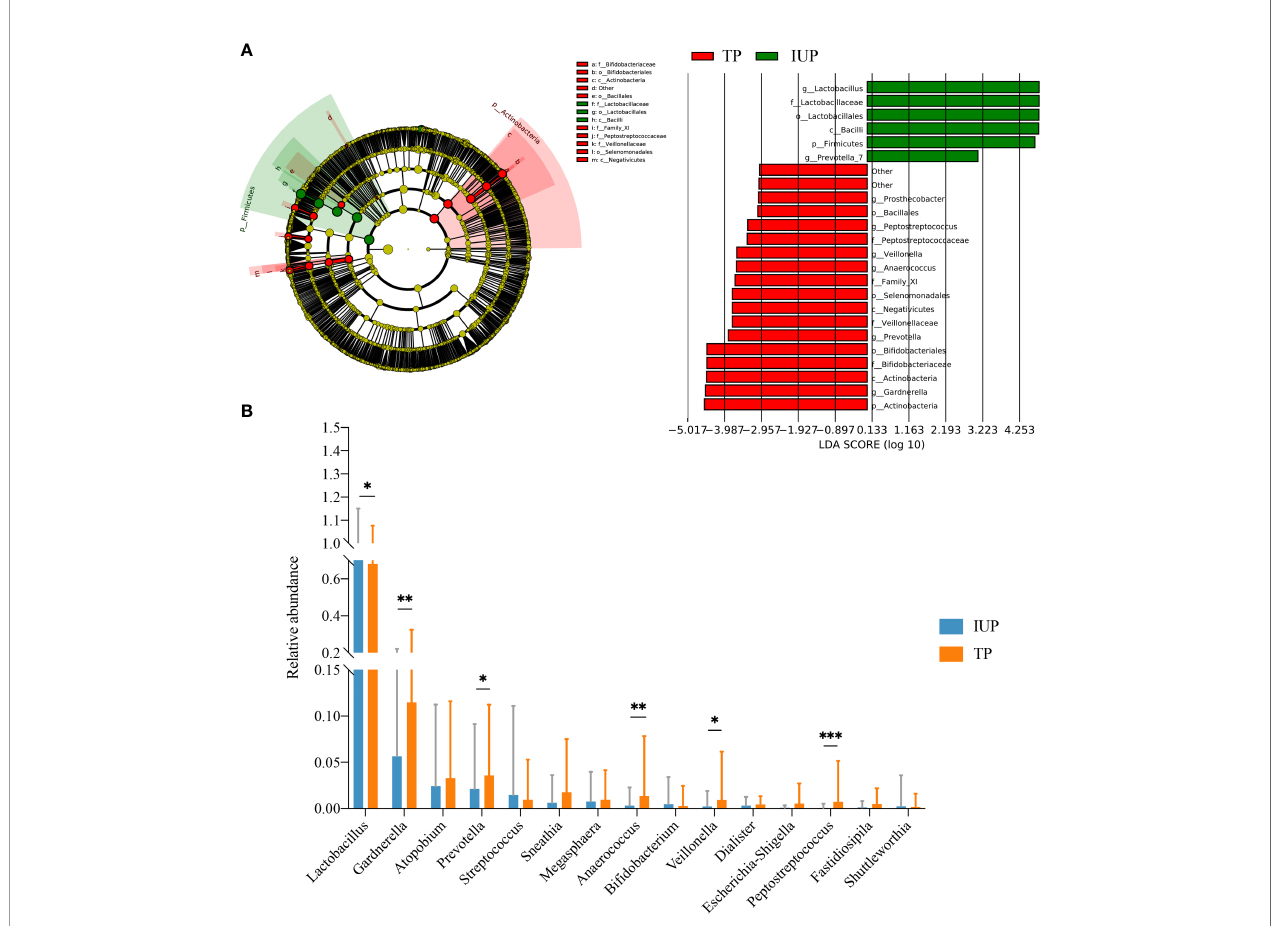
FIGURE 3 | Differences in vaginal microbiota composition between IUP and TP women. (A) Differences detected in the vaginal microbiota of IUP and TP groups, using LEfSe analysis. Bacteria with LDA scores >2.0 are shown. (B) The relative abundance levels of Lactobacillus , Gardnerella , Atopobium , Prevotella , Streptococcus , Sneathia , Megasphaera , Anaerococcus , Bi fi dobacterium , Veillonella , Dialister , Escherichia-Shigella , Peptostreptococcus , Fatidiosipila , and Shuttlemorthia were compared in individuals with TP or IUP. The p -value was determined by two-tailed Wilcoxon ’ s rank-sum test. * represented P value <0.05, ** represented P value <0.01, *** represented P value